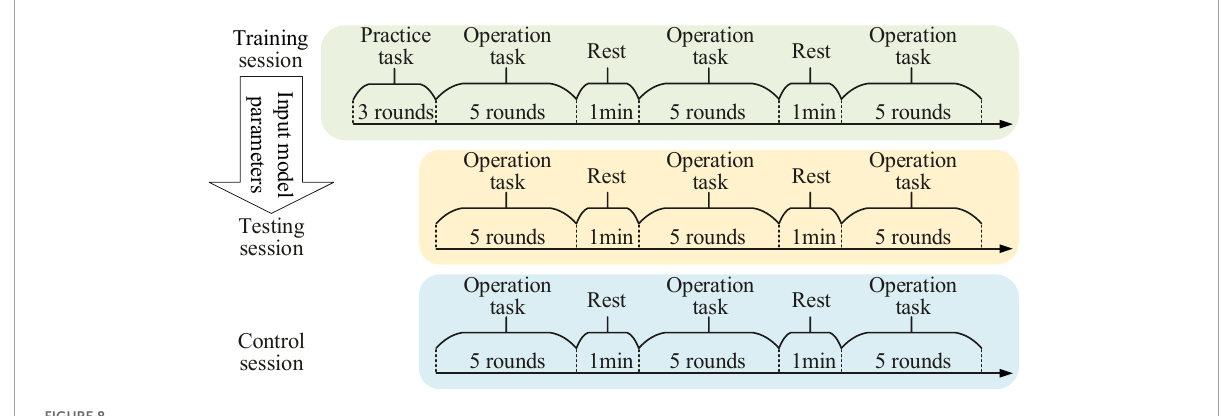
FIGURE8 The figure shows the experimental